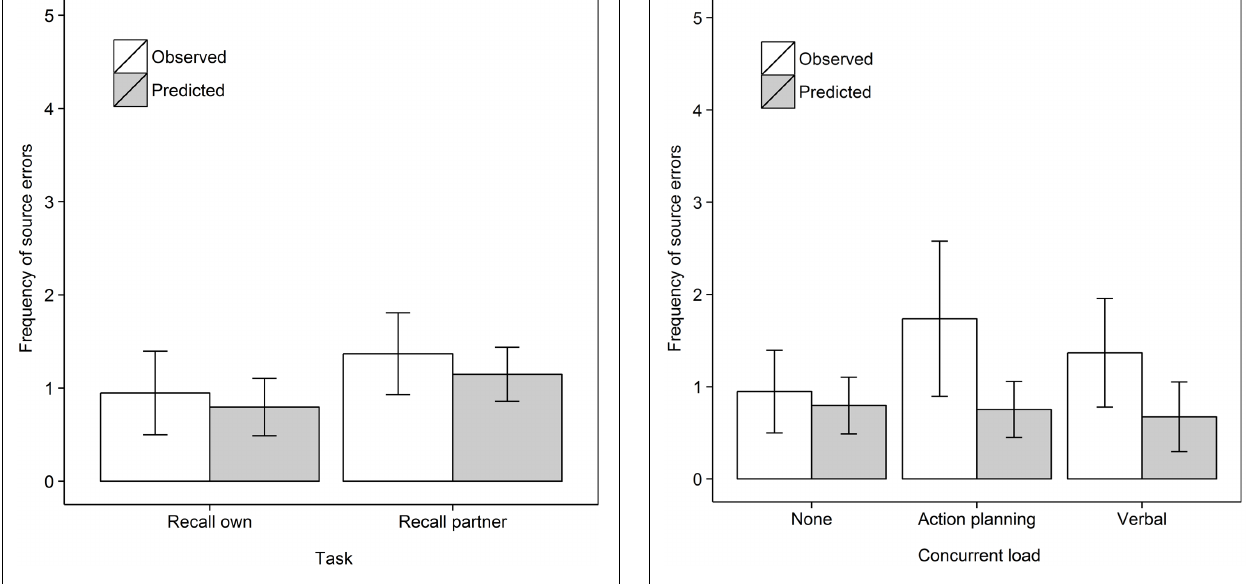
FIGURE 5 | Frequency of observed and predicted source errors in the Recall own and Recall partner task in Experiment 3 for the no concurrent load condition. The error bars are 95% within-subjects confidence intervals.